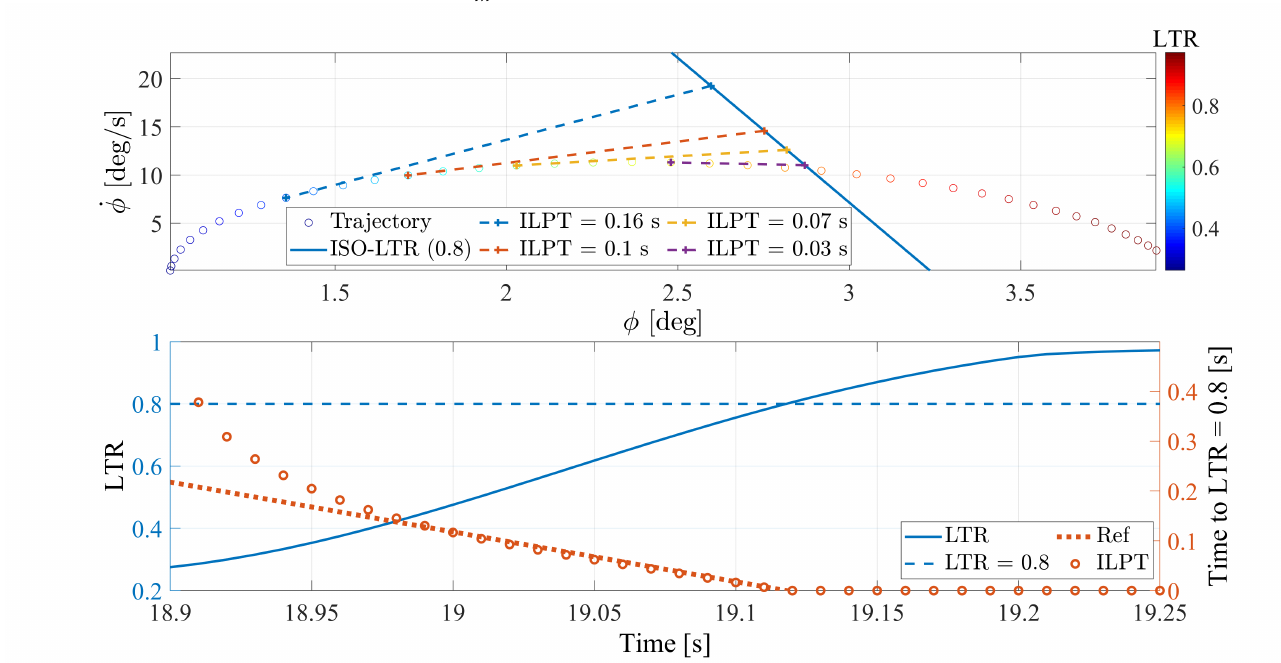
Figure 13. Fast ramp steering manoeuvre at 30km/h on a 10deg banked road: phase plane trajectory (top), LTR , reference ( T Ref ) and estimated ( ILTP ) time to reach LTR = 0.8 (down).